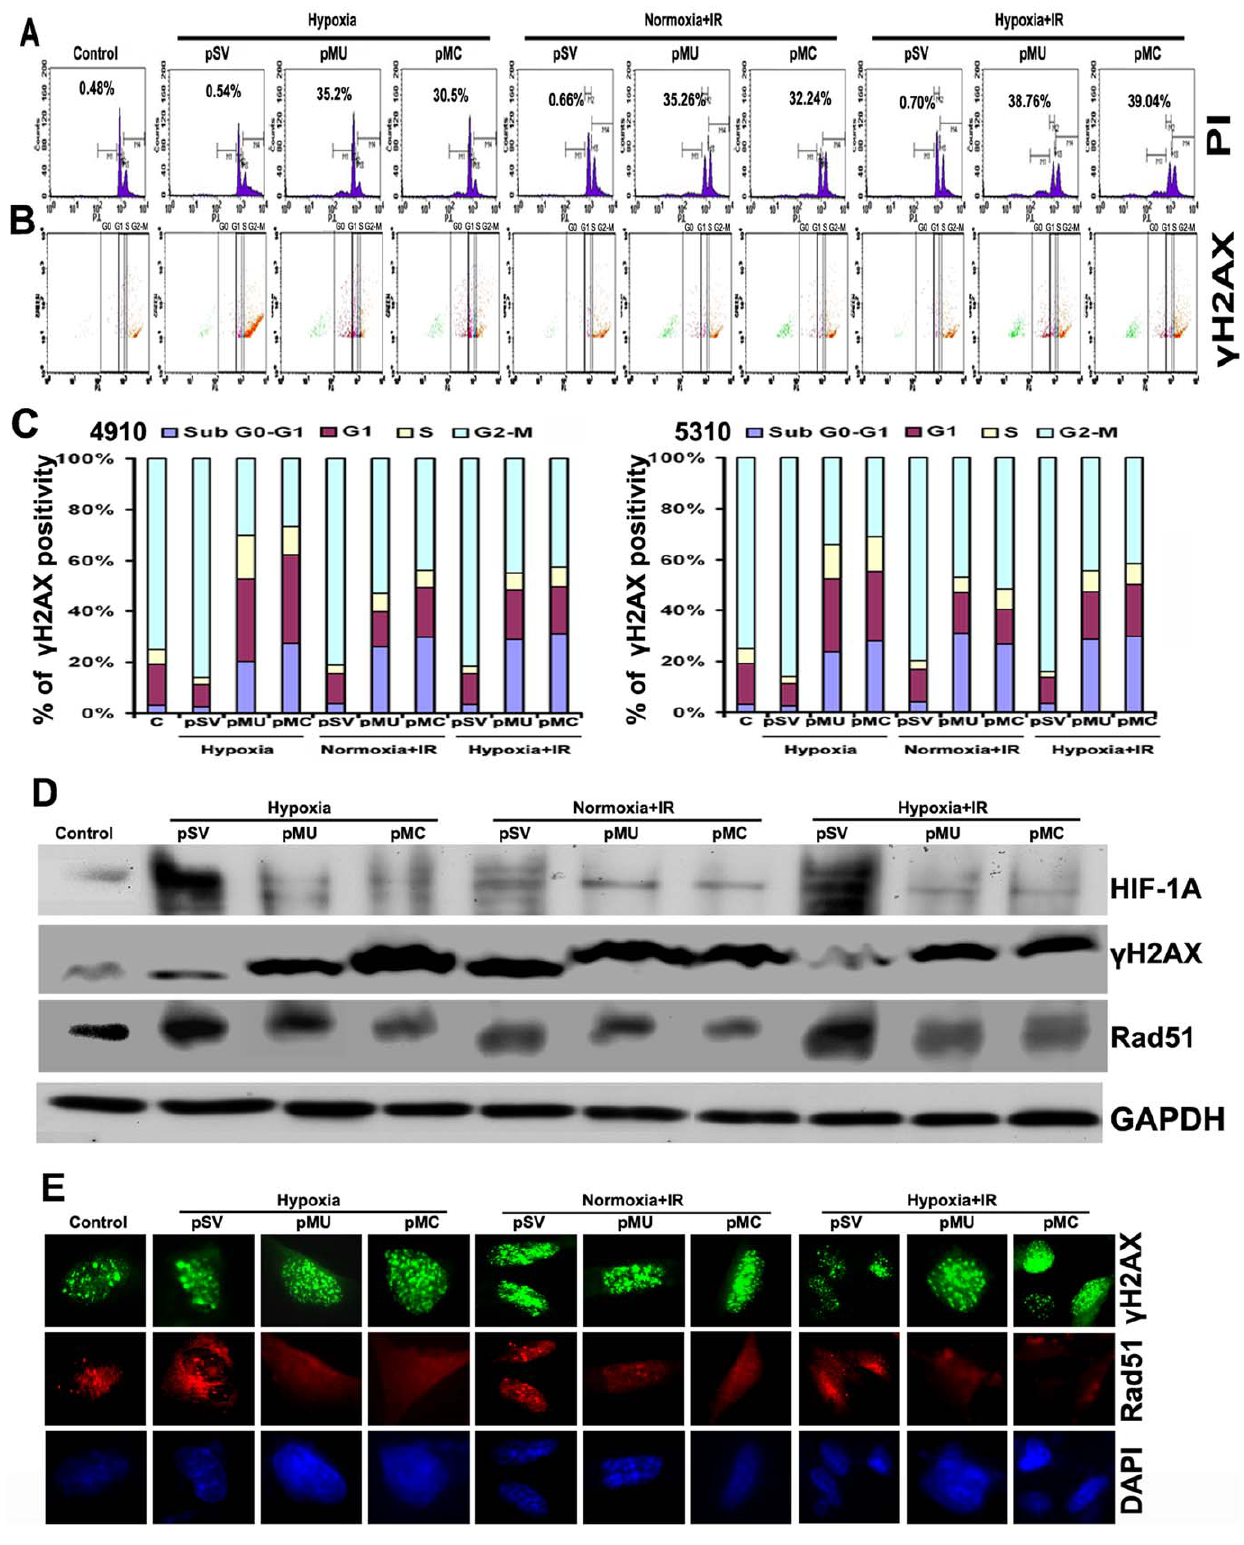
Figure 5. Effect of pMU and pMC treatments on c H2AX (NHEJ) and Rad51 (HR) expression in hypoxia alone , irradiation (IR) alone and hypoxia + IR exposed glioma cells. A. FACS analysis shows cell cycle distribution in pMU- and pMC-treated hypoxic, IR and hypoxic + IR exposed 5310 glioma xenograft cells. 5,000 cells were analyzed during each process. Number(%) represent respective apoptotic cell population in samples. B. FACS analysis showing dot plot of gated c H2AX expression after pMU and pMC transfection in hypoxic, IR and hypoxic + IR exposed 5310 glioma xenograft cells along with pSV and control. C. Bar graph showing number of cells expressing c H2AX in sub G 0 -G 1 , G 1 , S and G 2 -M phase in